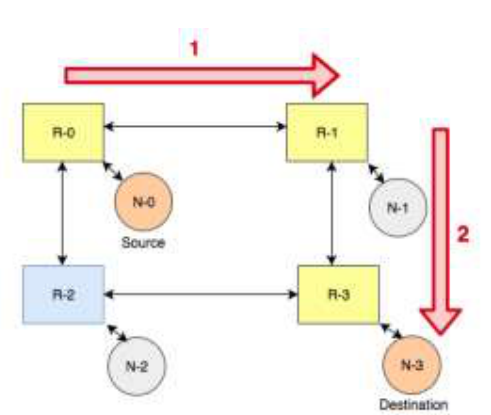
Figure 3. XY routing algorithm in 2x2 Mesh